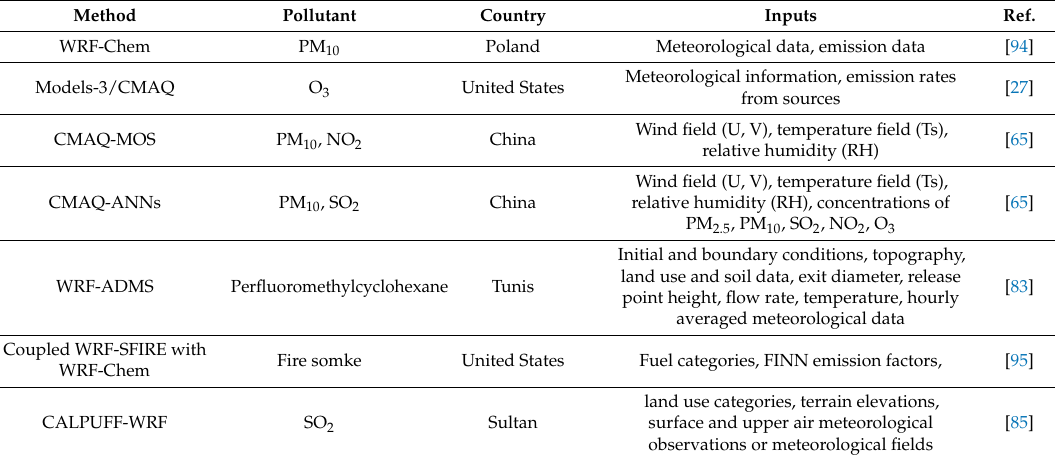
Table 15. Recent studies on air pollution forecasting using three dimensional